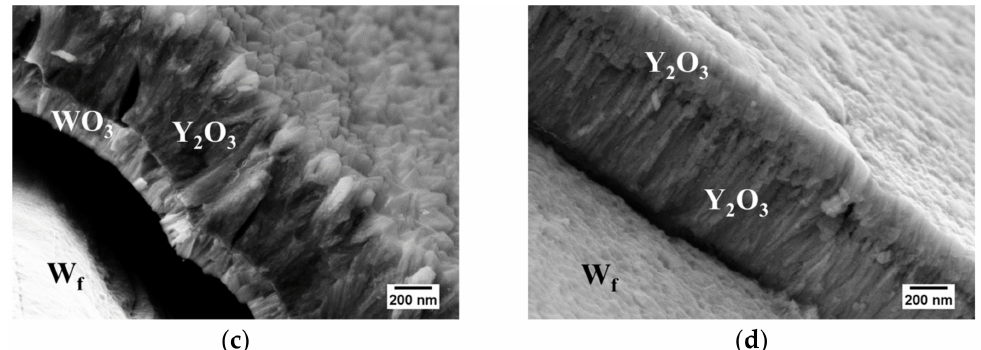
Figure 2. The SEM fracture surfaces of ( a ) CVD_Y_H 2 , ( b ) CVD_Y_H 2 + PA, ( c ) CVD_Yt_O 2 , and ( d ) PVD samples (delamination seen between the W f and the coating is caused by the cutting technique used to obtain the fracture